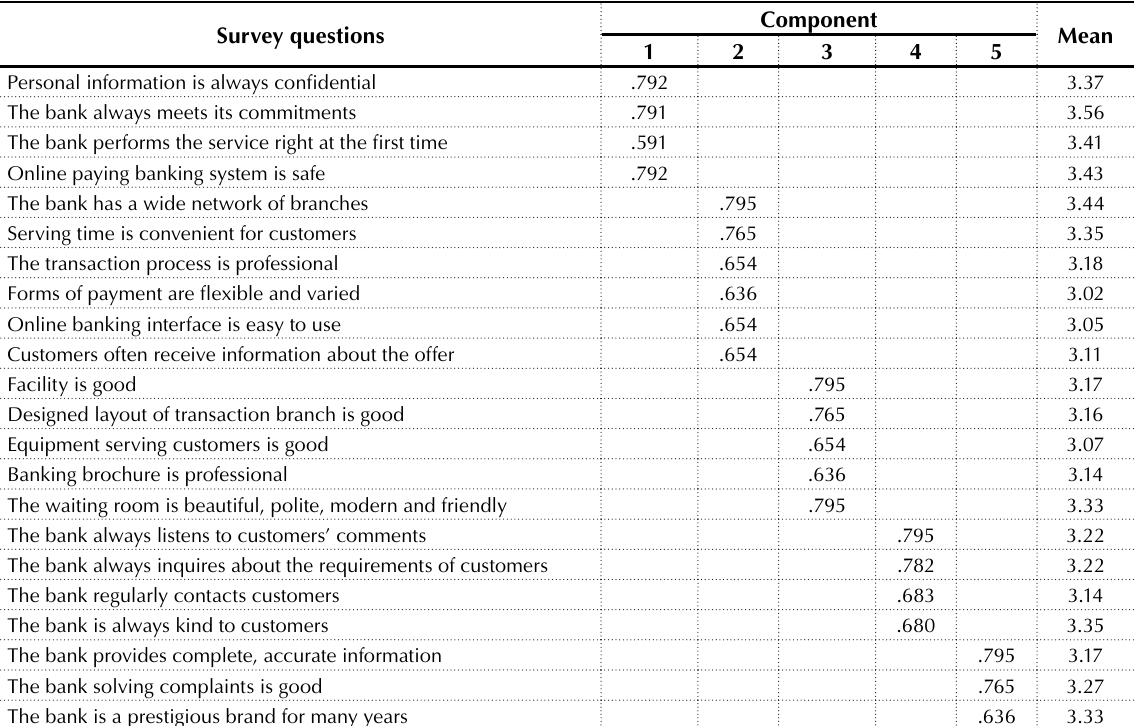
Source: The researcher’s collecting data and